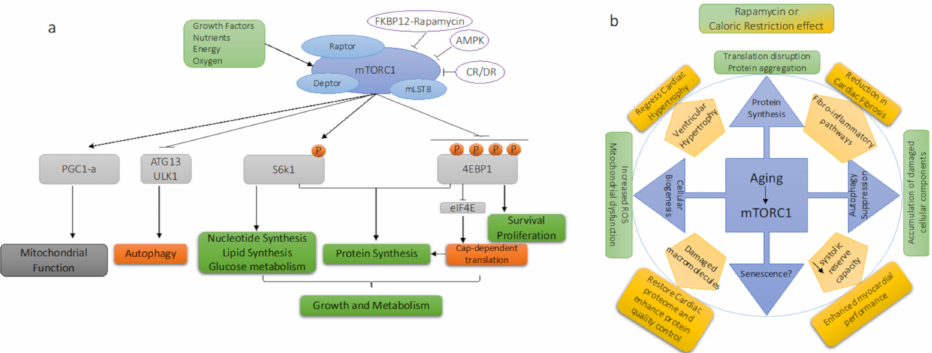
Figure 1. ( a ) mTORC1 signaling; ( b ) mTORC1 signaling in aging and cardiac aging modulated by Rapamycin and/or Caloric